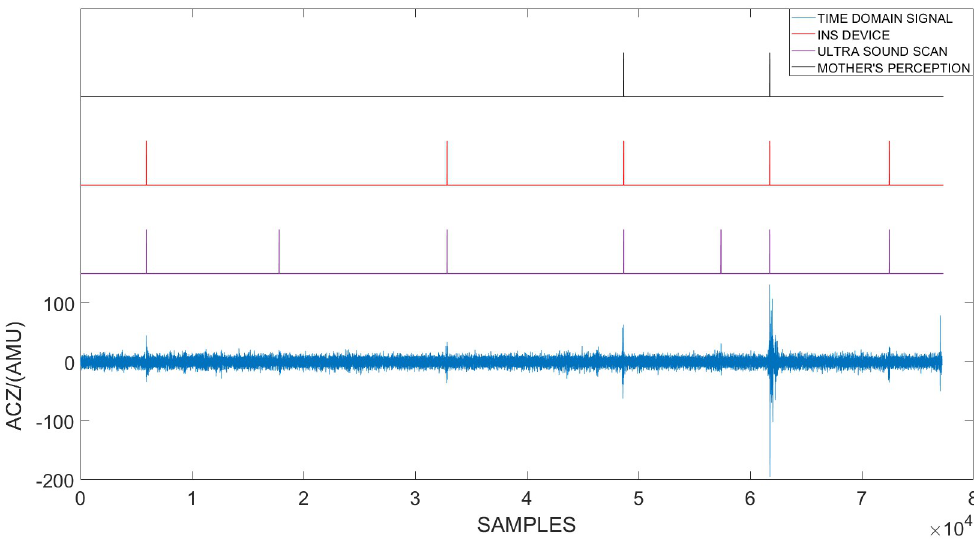
Fig 6. The time-domain signal of a singleton breached pregnancy observed by the sensor and the fetal movement identified by each method. In this figure the time domain accelerometric data along the Z-Axis recorded during a single session is plotted against the sample number. This session was conducted on a pregnant mother with a singleton breached pregnancy. During the session three methods were utilized to identify the occurrence of a fetal movement. They are: An abdominal Ultrasound scan, mother’s perception and the in-house fabricated device. The instances where each method identified the occurrence of a fetal movement are indicated by peaks.